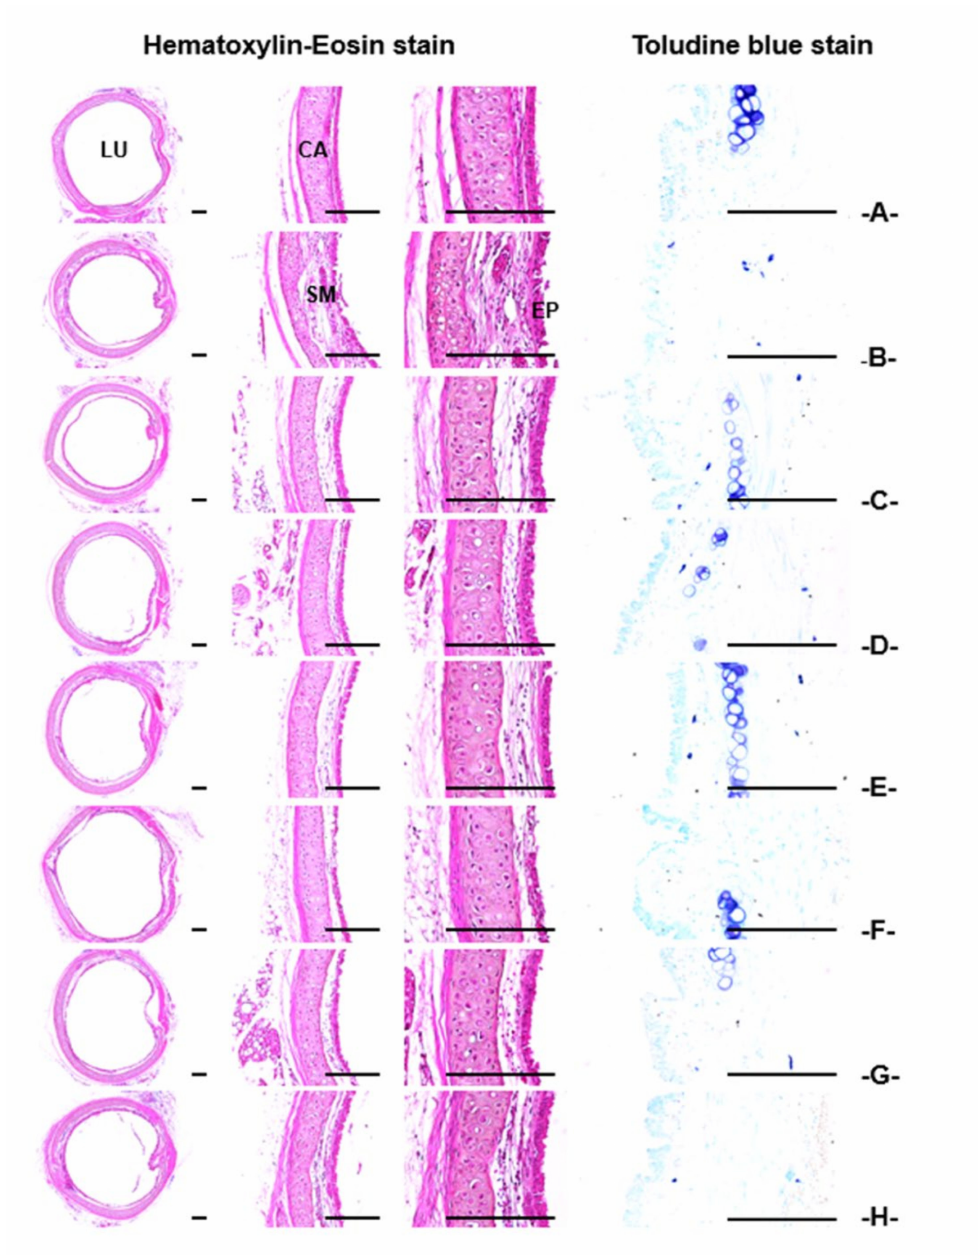
Figure 2. Changes in the histological features of trachea in mice. Different treatment groups as followed by the ( A ) intact vehicle control, ( B ) NH 4 OH control, ( C ) TB 50 mg/kg + NH 4 OH, ( D ) AR 400 mg/kg + NH 4 OH, ( E ) KOG 400 mg/kg + NH 4 OH, ( F ) SKOG 400 mg/kg + NH 4 OH, ( G ) SKOG 200 mg/kg + NH 4 OH, and ( H ) SKOG 100 mg/kg + NH 4 OH. Scale bar = 120 µ m. LU: Lumen; CA: Cartilages; SM: Submucosa; EP: